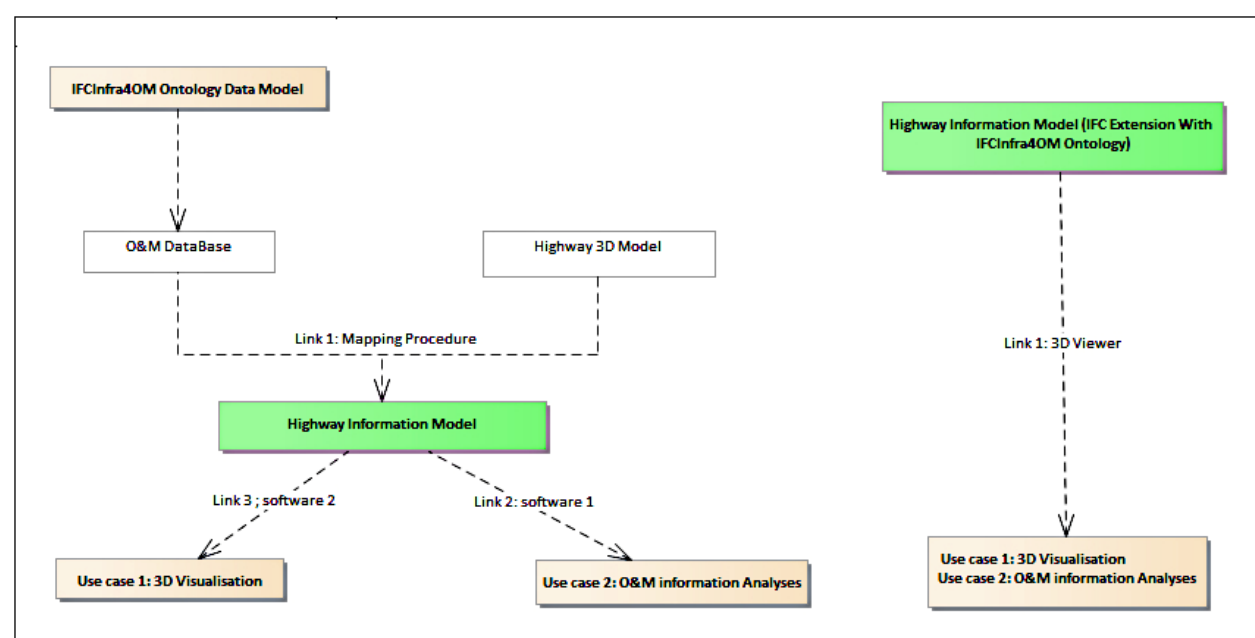
Figure 13. OpenBIM ( Right Diagram) and ClosedBIM ( Left Diagram) process comparison diagram. The extension of the IFC schema is carried out based on the BuildingSmart